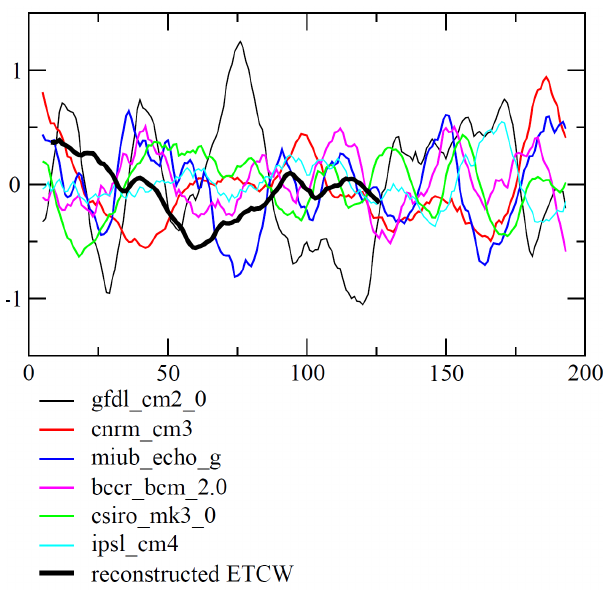
Fig. 8. Inter-decadal variations of the winter (November–April) Arctic sea ice area anomalies (10 6 km 2 ) as simulated in selected CMIP3 control experiments and the ETCW sea anomaly as esti- mated from model sensitivity experiments (Fig. 7). All time series are smoothed with 11-yr running mean